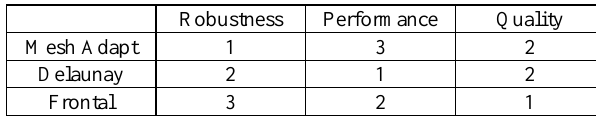
Figure 1. Boolean solid of test area